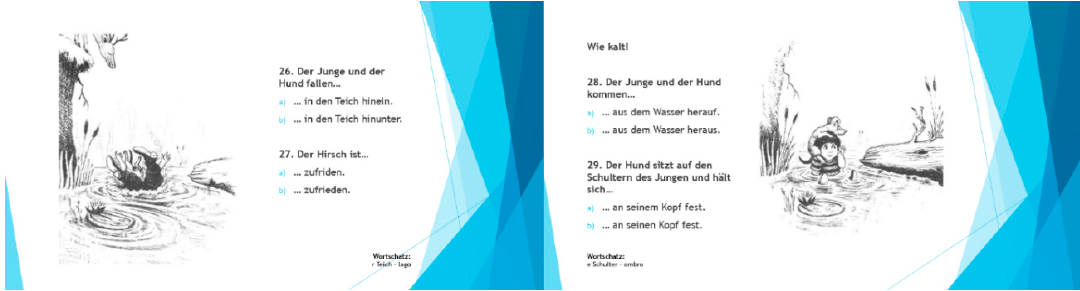
Figure A38. Posttest: Binary-choice recognition task.